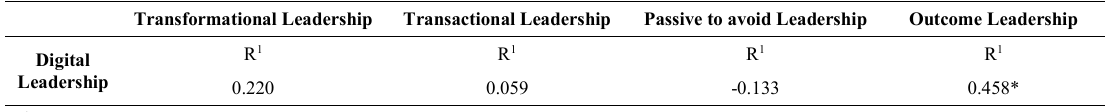
Table 9. Digital Leadership & Leadership Types